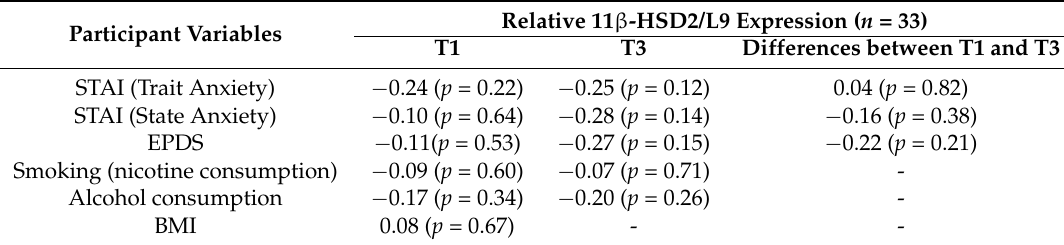
Table 1. Pearson Correlations between 11 β -HSD2 Gene Expression, Maternal Mood and Participant Characteristics during Trimester 1 and